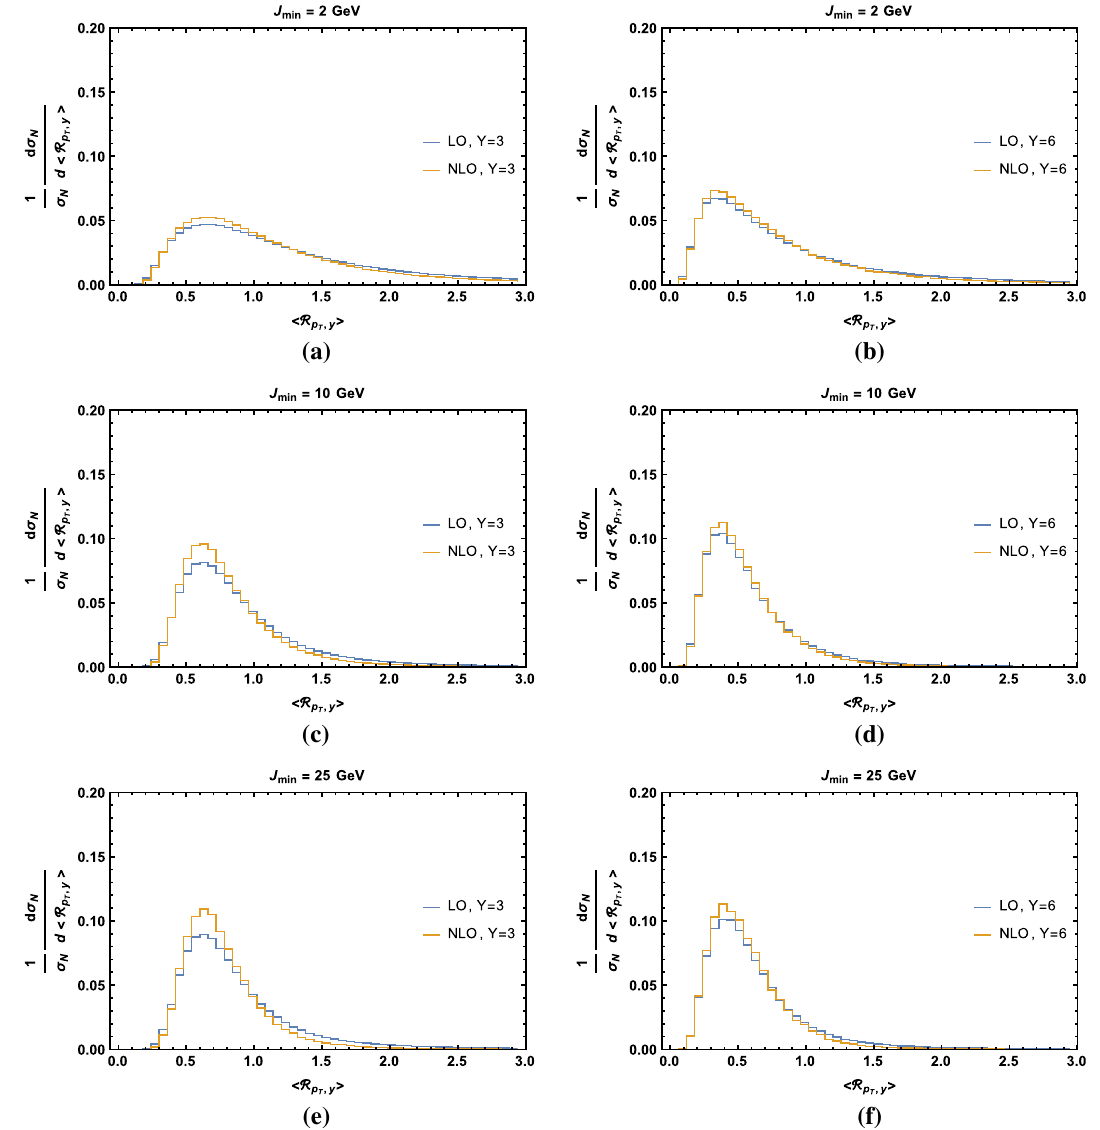
(cid:11) distributions for multiplicity N = 4, rapidity differences Y = 3 (left) and Y = 6 T , y